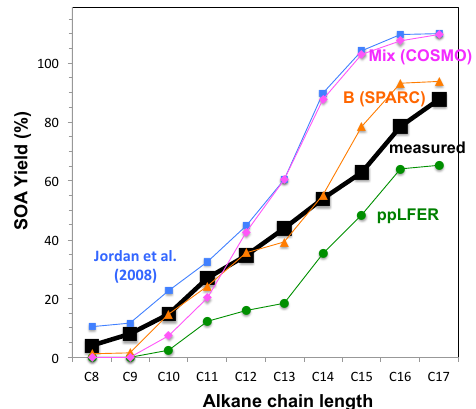
Figure 11. SOA yield from chamber experiments (black squares and line) compared to simulated results using the K i, WIOM data sets obtained by polyparameter linear free energy relationships (av- erage of four, green circles), by using SPARC and the surrogate B by Kalberer et al. (2004) (orange triangles), or by using COSMO-RS and the actual composition of the simulated SOA phase (magenta diamonds). For comparison the simulated results for the nominal case by Jordan et al. (2008) are shown (blue squares). Note that yields exceeding 100% are possible because they are calculated on a mass basis (mass of SOA formed for mass of alkane initially